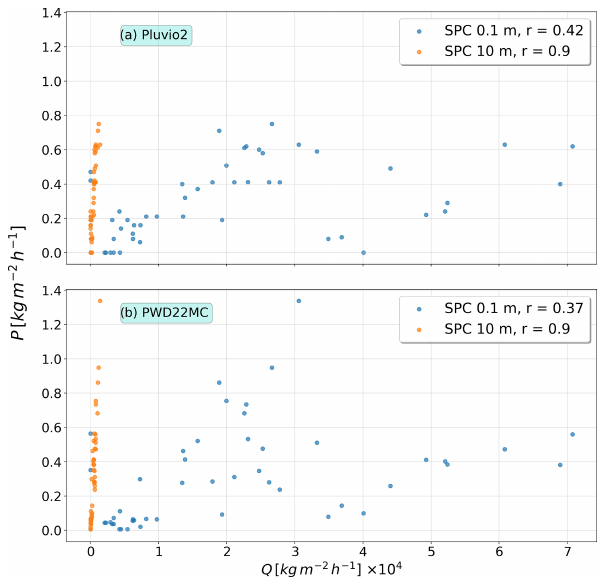
Figure 14. Scatter plots of sensor snowfall rates ( y axis) vs. SPC mass flux ( x axis) for the drifting snow event on 24–25 Febru- ary 2020 for (a) Pluvio2 and (b)